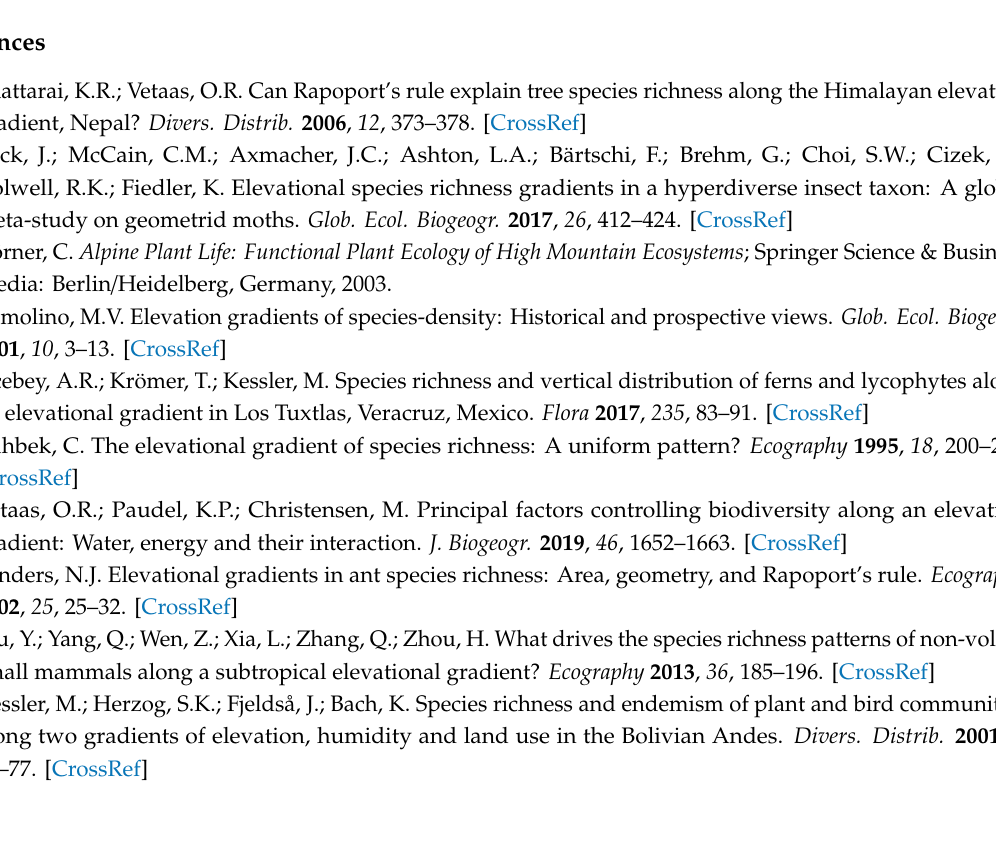
Figure S1: Relationship between environment variables along elevation gradients in Nepal, Figure S2: Moran’s Index correlograms for gymnosperms richness and residuals autocorrelation, Table S1: Results of variation partitioning showing the percentage contribution of predictor variables to determine the species richness of gymnosperms along elevation gradients, Table S2: List of species of gymnosperms reported from Nepal along with the lower and upper elevational limits expressed in meter (m) above sea level, Table S3: Results of principal components analysis using energy-water, physical tolerance and climatic seasonality sets of